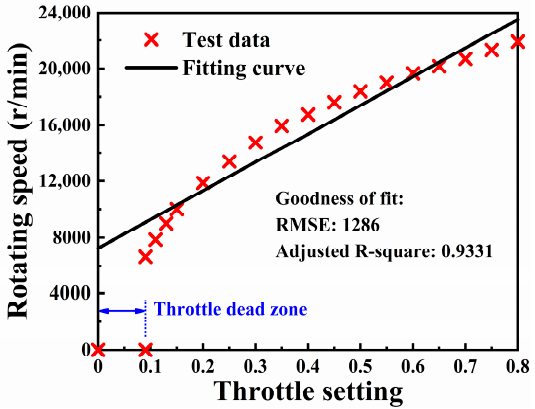
Figure 13. Fitting curve of rotating speed versus throttle setting.